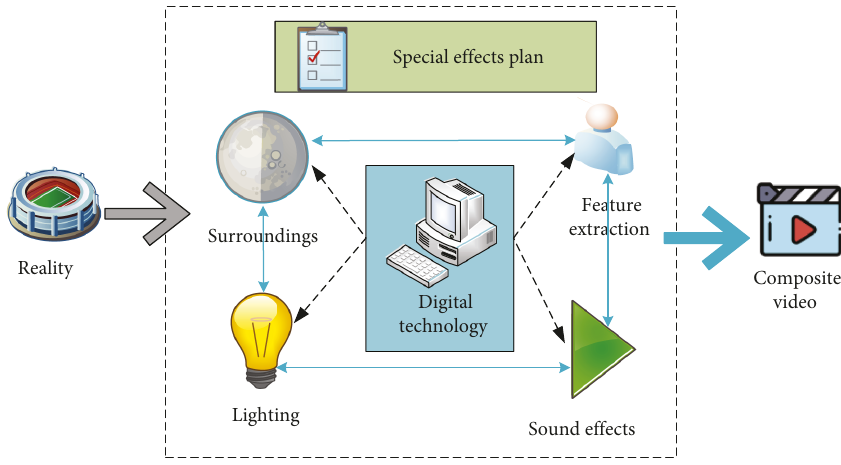
Figure 4: Application of digital technology in special effects for film and television.